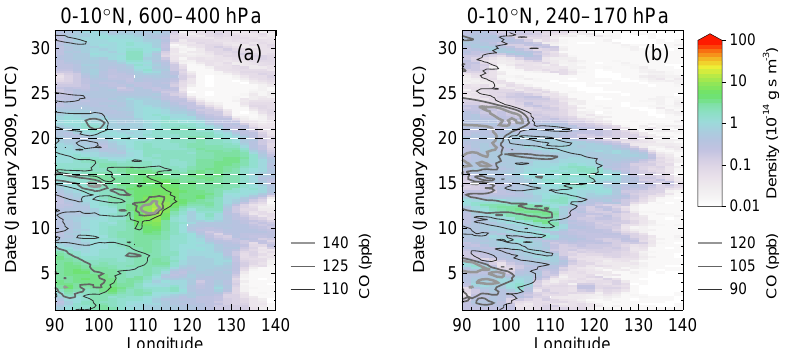
Figure 5. Time-integrated particle (i.e. trajectory) density, as a function of longitude and time through January 2009, resulting from a midlatitude particle source in NAME. (a) shows particle density between 600 and 400hPa averaged between 0 and 10 ◦ N. (b) shows particle density between 240 and 170hPa, also averaged between 0 and 10 ◦ N. The contours show CO from the MACC reanalysis at, respectively, 500 and 200hPa, for the same spatial and temporal dimensions.